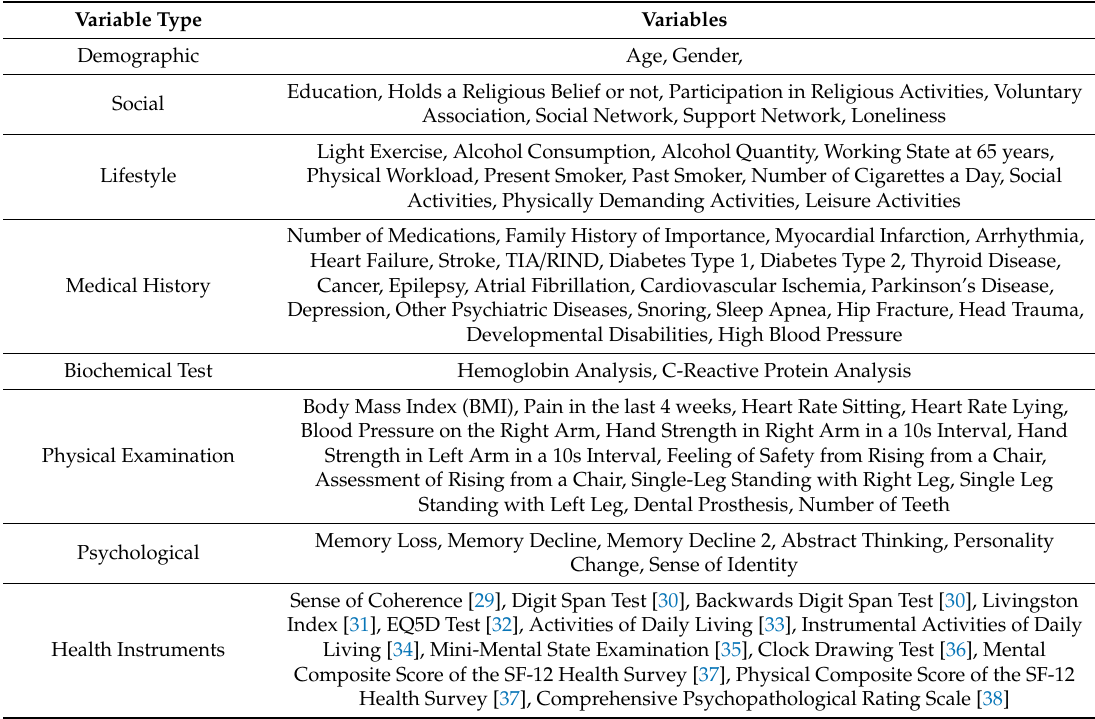
Table 2. List of input variables that were selected by dementia